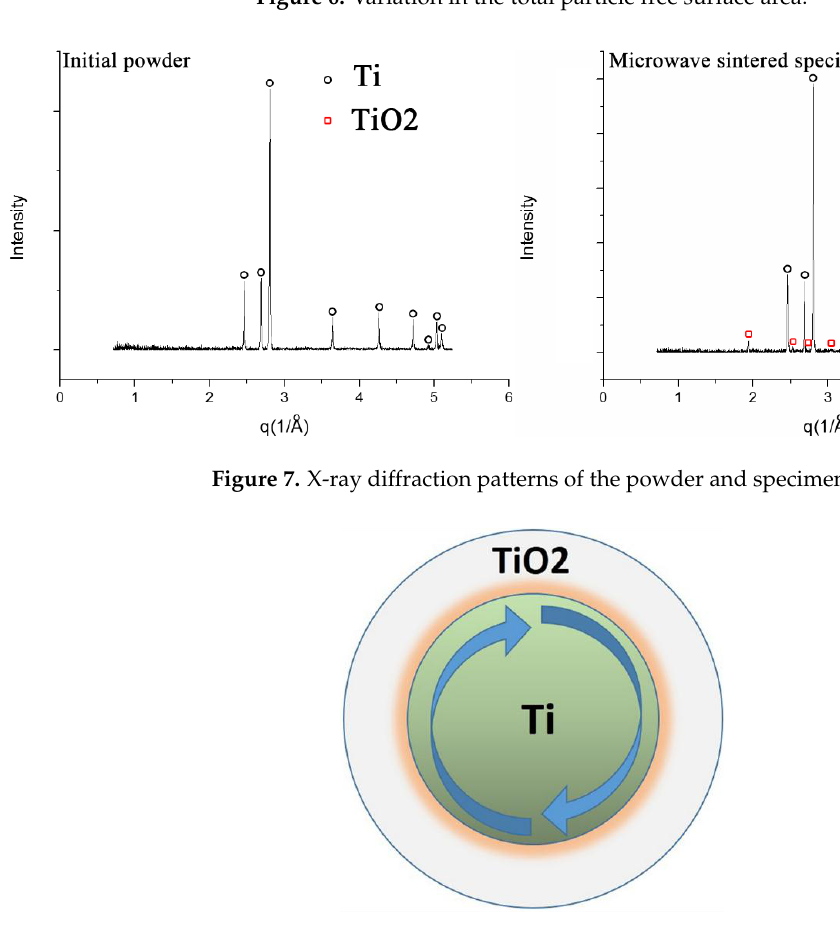
Figure 6. Variation in the total particle free surface area.